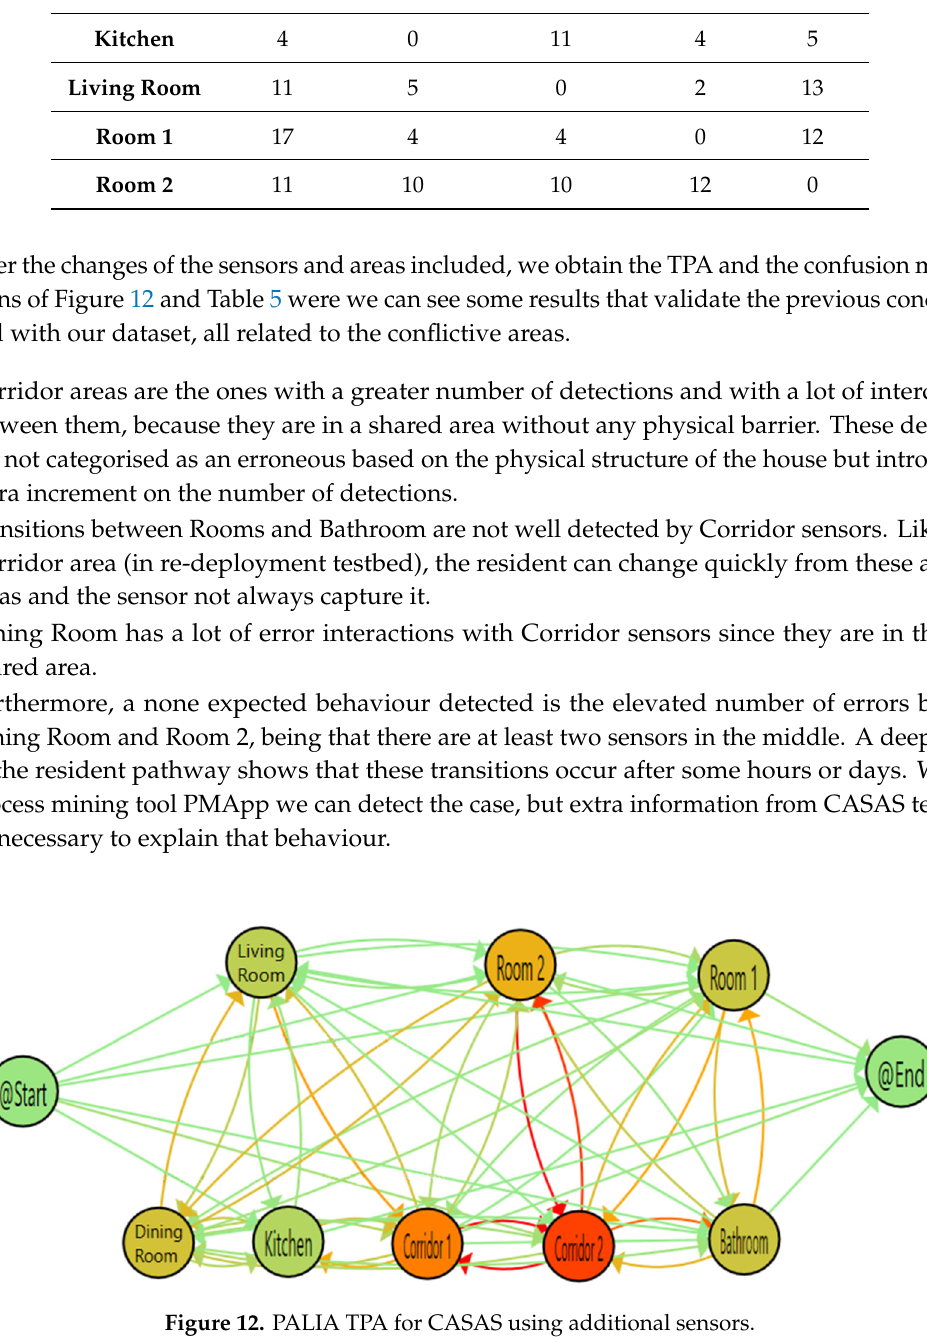
Table 4. Confusion matrix of transitions for CASAS using wide-area sensors.